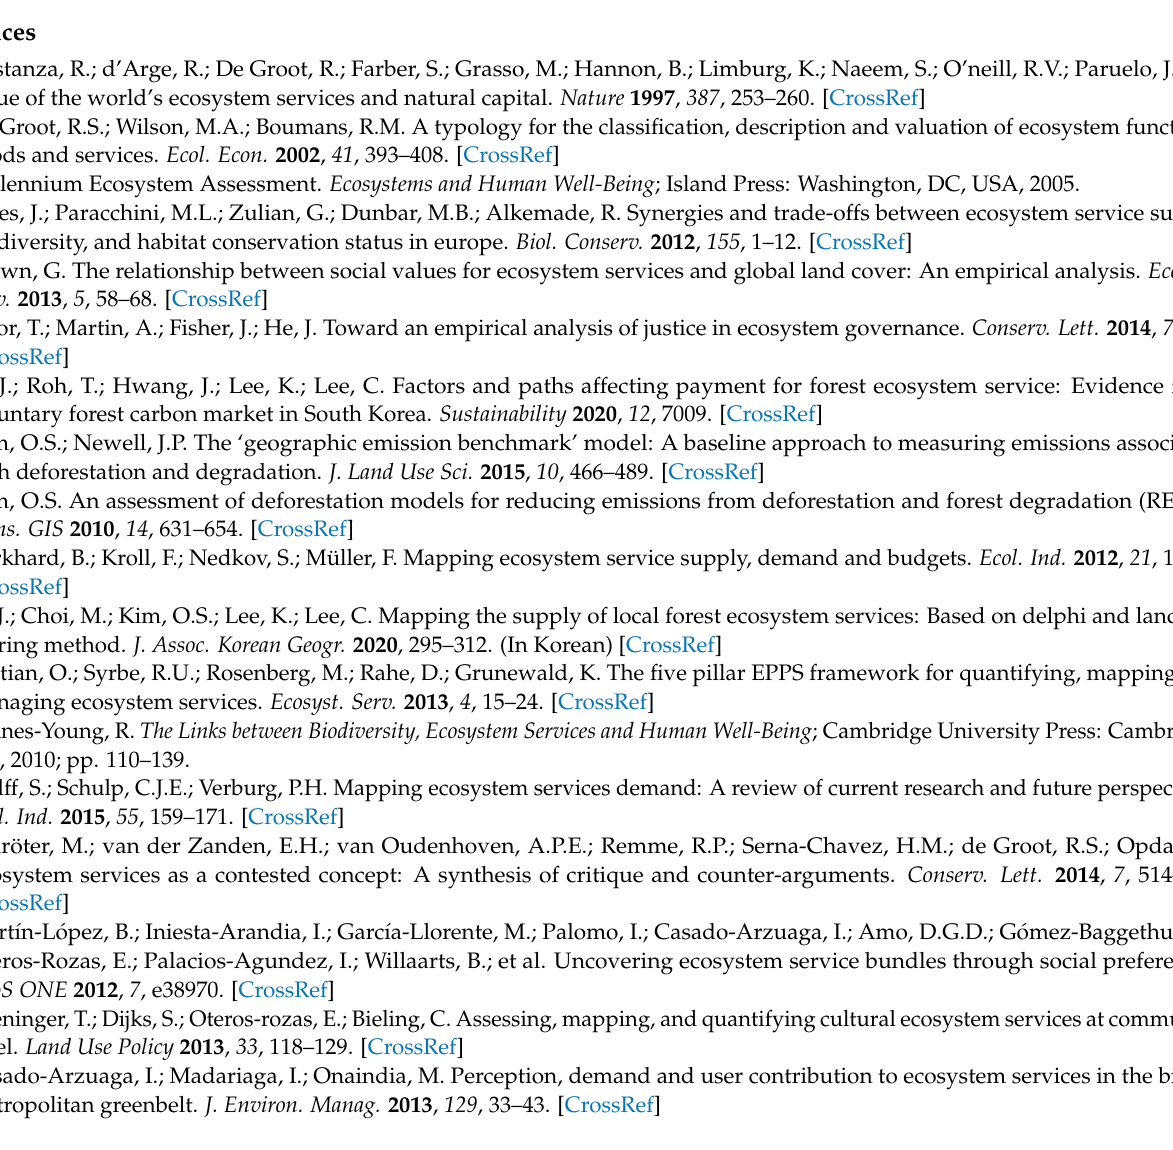
Figure S1. Word cloud results of (a) Gariwangsan and (b) Yeoninsan in